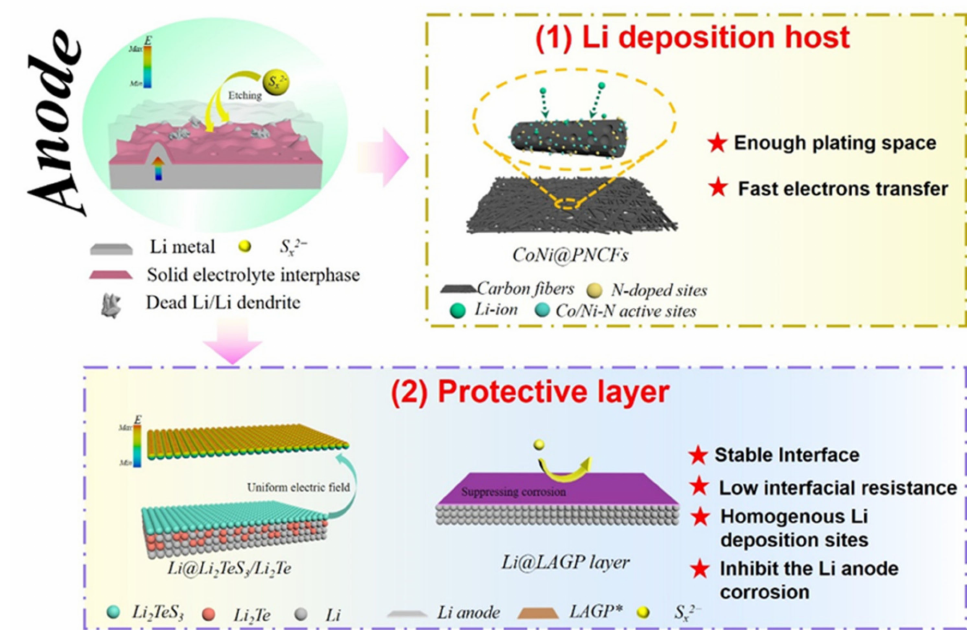
Figure 5. Approaches for stabilizing the lithium metal anode in Li–S pouch cells. ( 1 ) Nanostructured lithium deposition host and ( 2 ) artificial protective layers are the two dominant strategies being pursued for overcoming lithium volume change, dendrite growth, SEI cracking, and corrosion of the lithium metal